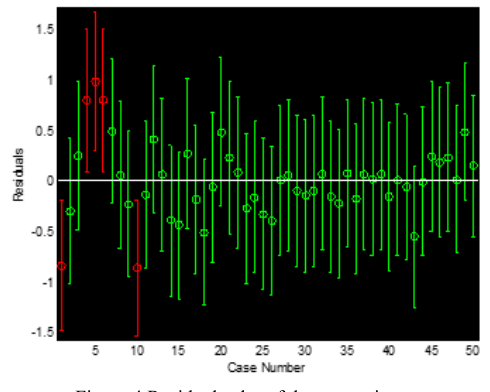
Figure.4 Residuals plot of the regression TABLE II ． Coefficients for the QoE function in Equation (5)